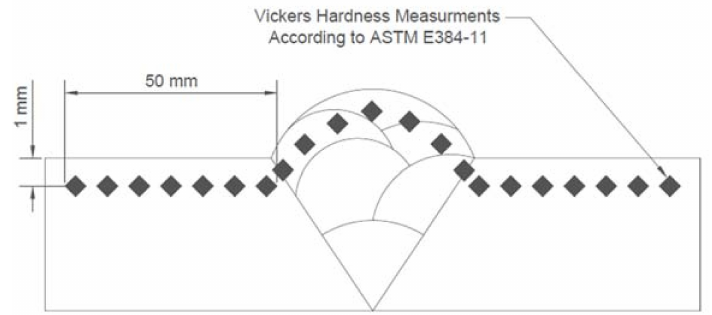
Figure 4. Micro-hardness measurement